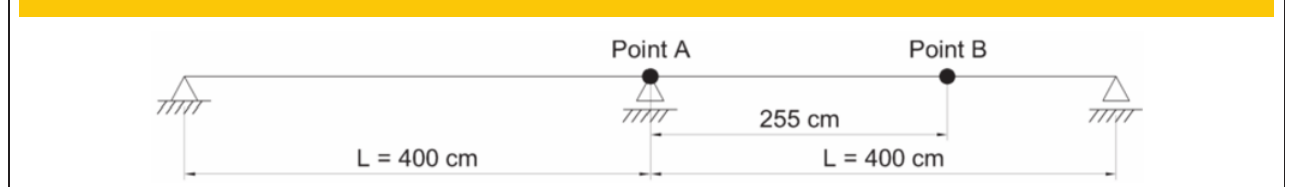
Figure 5 – Failure modes defined by the respectively cross-sections